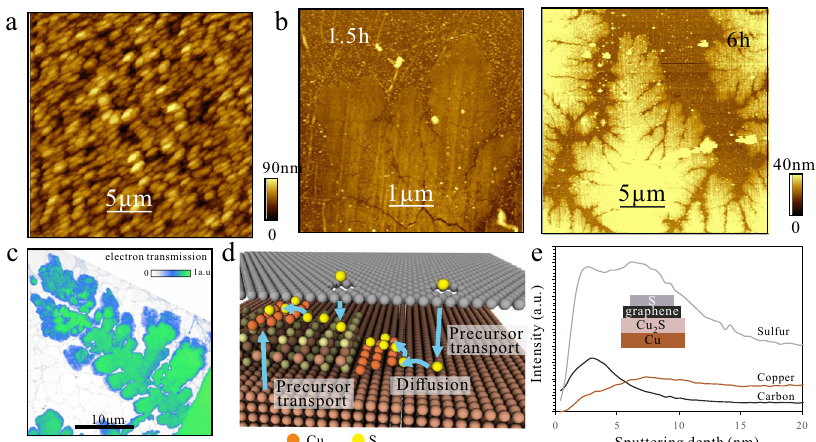
Fig. 2 Properties of planarized reactions. a Atomic force microscopy (AFM) image of copper sulfurized without graphene planarizer, b AFM images of planarized growth results after different growth durations, c transmission electron absorption micrograph of planarized Cu 2 S. d proposed mechanism of planarized growth. e Secondary Ion Mass spectroscopy characterization of material, (inset) schematic of material structure, indicating the presence of elemental sulfur contamination on top of the